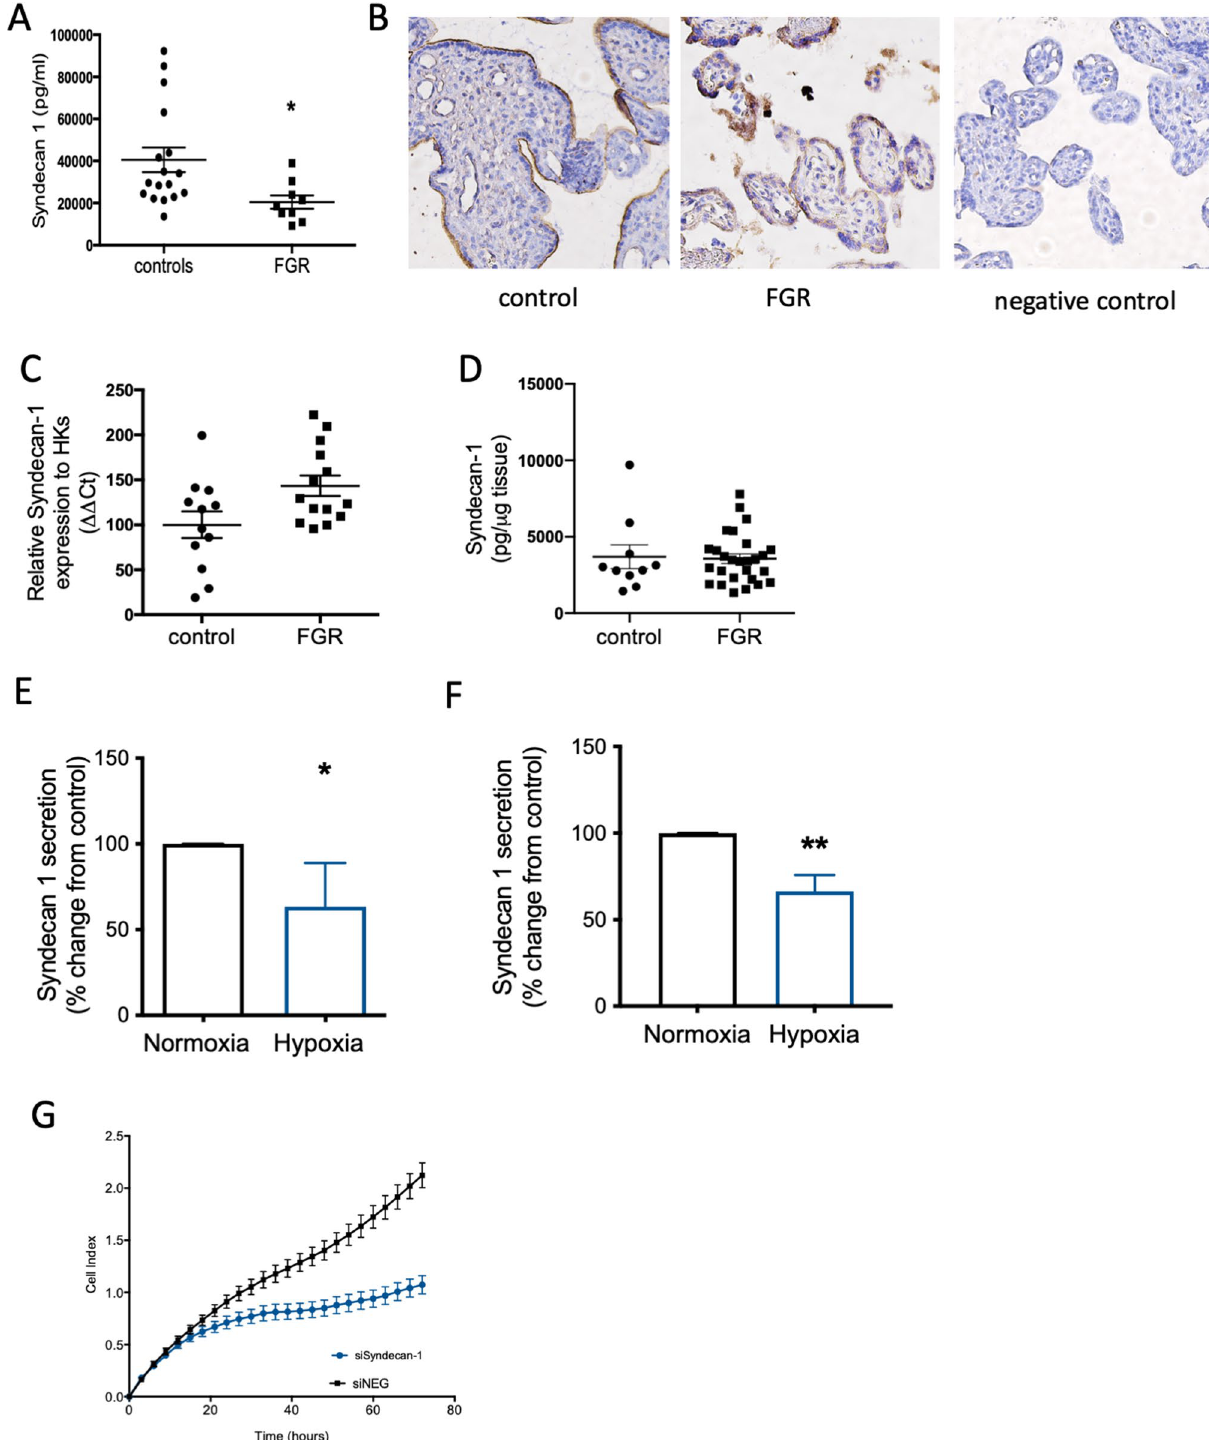
Figure 2. Syndecan-1 is reduced in early onset FGR and by hypoxia and may be important in placental proliferation. Circulating maternal syndecan-1 was measured in a cohort of women who delivered a preterm (< 34 weeks’ gestation— Cohort 5) FGR infant (n = 10) relative to women who delivered healthy infants at term (n = 18 matched for gestation at blood sampling). Circulating syndecan-1 was significantly reduced in the FGR cohort ( A ). Syndecan-1 was localised to the syncytiotrophoblast layer in both pre-term control and FGR placentas ( B ). In placentas obtained from women who delivered a preterm FGR infant (n = 21) relative to preterm controls (n = 12), syndecan-1 mRNA expression was not significantly changed ( C ). Similarly, no significant difference in protein expression between FGR (n = 27) and preterm control (n = 10) placentas was identified ( D ). When isolated primary cytotrophoblast ( E ) or syncytialised first trimester stem cells ( F ) were exposed to hypoxia (1% O 2 ), syndecan-1 secretion was significantly reduced. Finally, in the HTR8/ SVneo cell line, when syndecan-1 was silenced using siRNA, we observed a reduction in cellular proliferation measured using xCELLigence ( G ). Data expressed as mean ± SEM. *p < 0.05, **p <